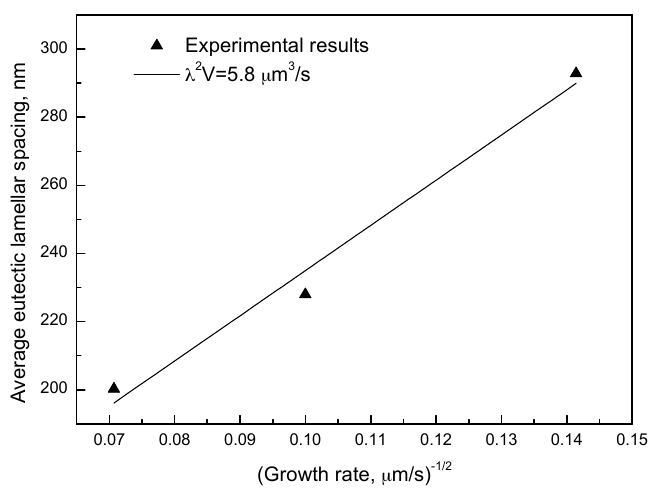
Figure 3. The ELS of as-DS Ag-Cu alloys as a function of the inverse square root of growth